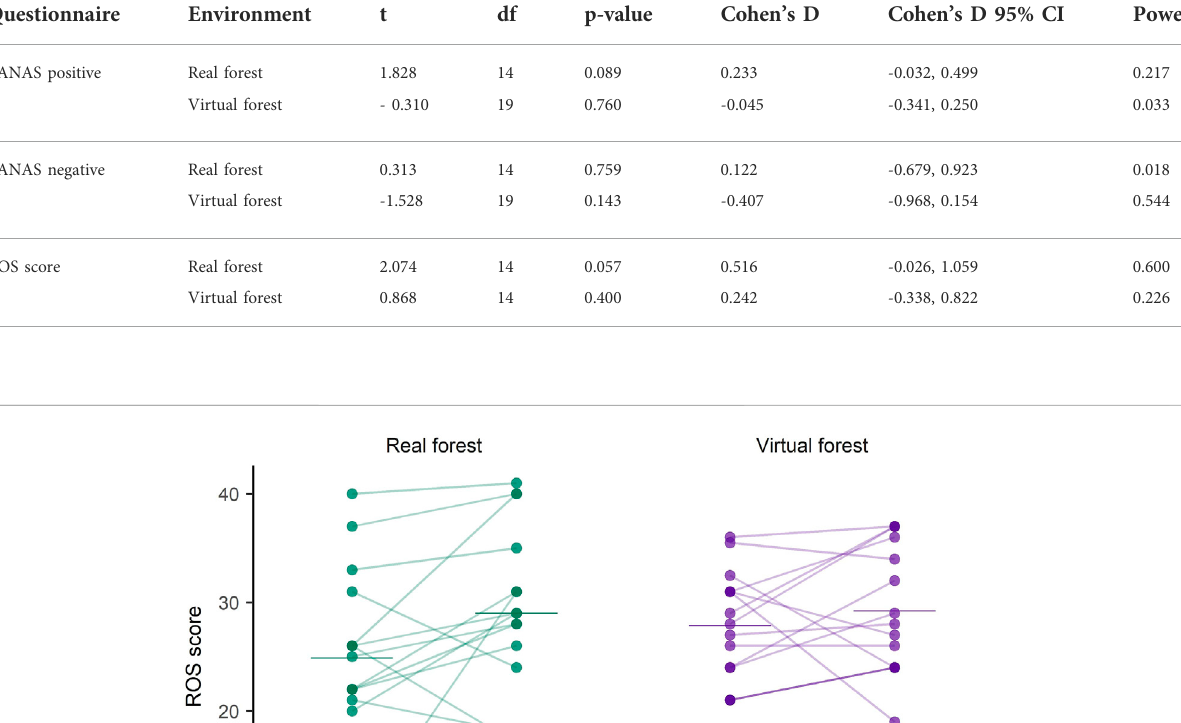
TABLE 2 Calculated effect sizes and power for t-test pairwise comparisons for the two main outcome measures. Questionnaire